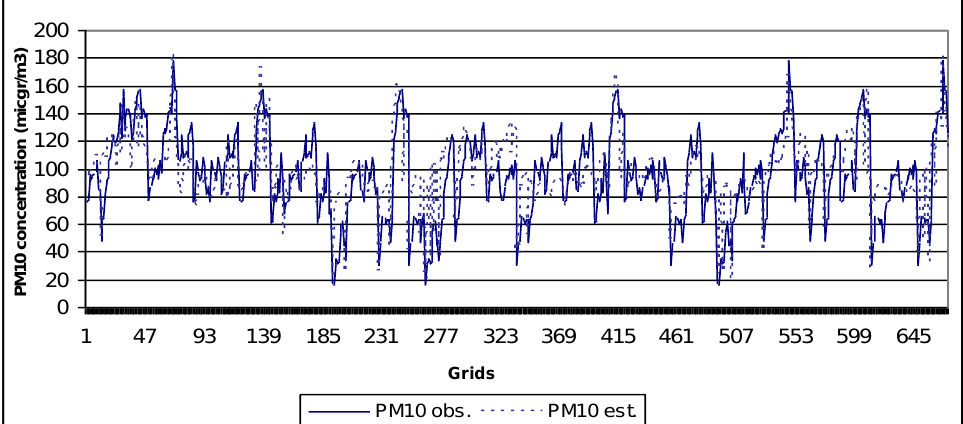
Figure 5. Comparison between PM Statistical